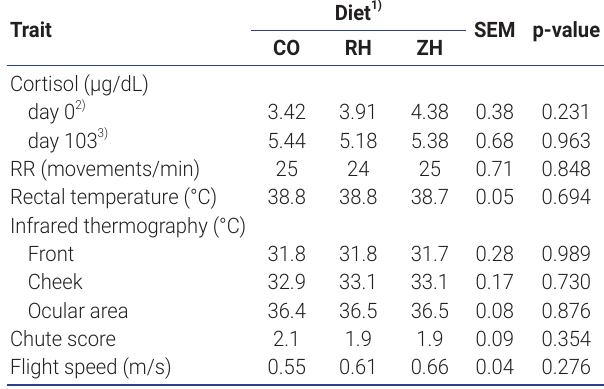
Table 4. Effects of feeding beta-adrenergic agonists (β-AA) on corti